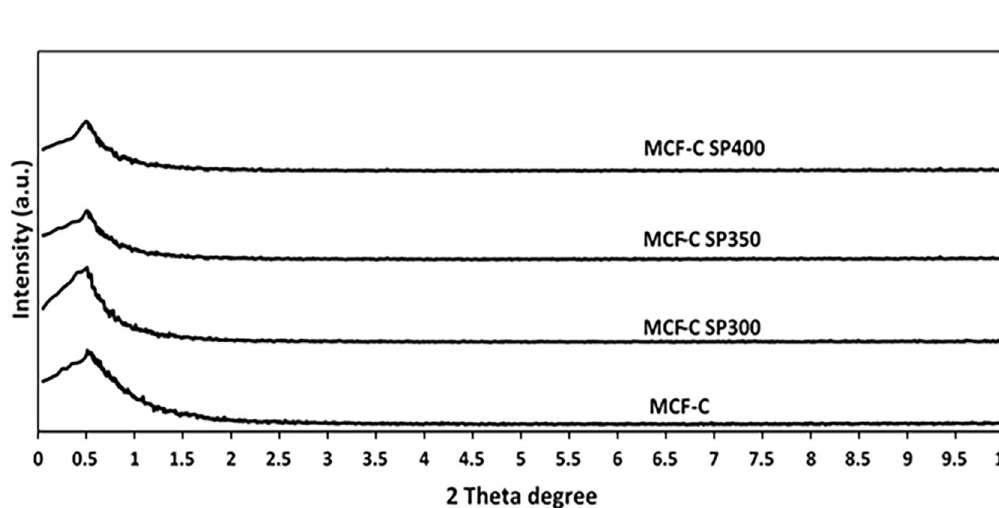
Figure 4. XRD pattern of the fresh and spent catalysts.